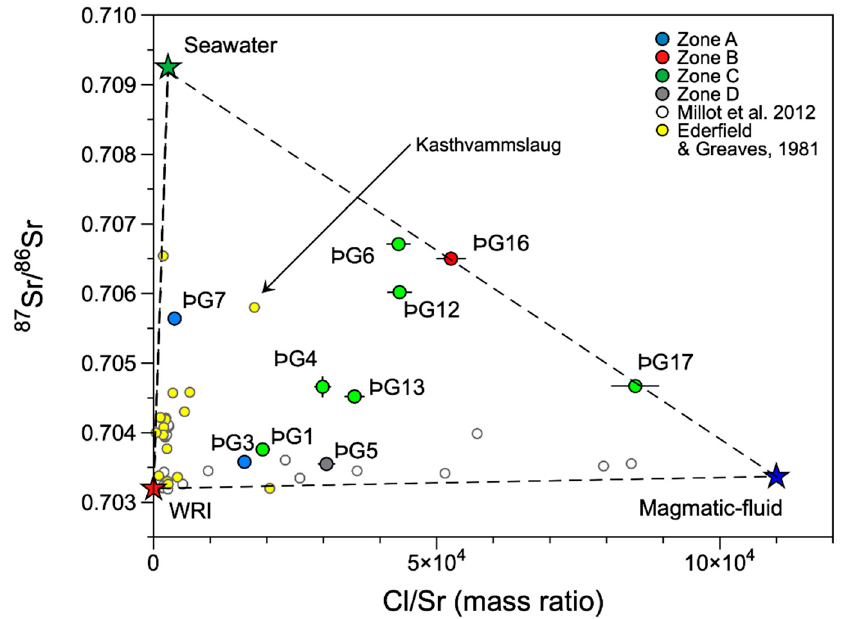
Figure 3. The Cl/Sr mass ratio vs. the 87 Sr/ 86 Sr ratio of Theistareykir hydrothermal fluids (the color represents the subzones of the field, see Section 2 for details), compared to the literature data from other geothermal fields of Iceland. See the text for details on the endmember compositions. The white dots are data from Figure 5 of [7], redrawn (data unpublished).